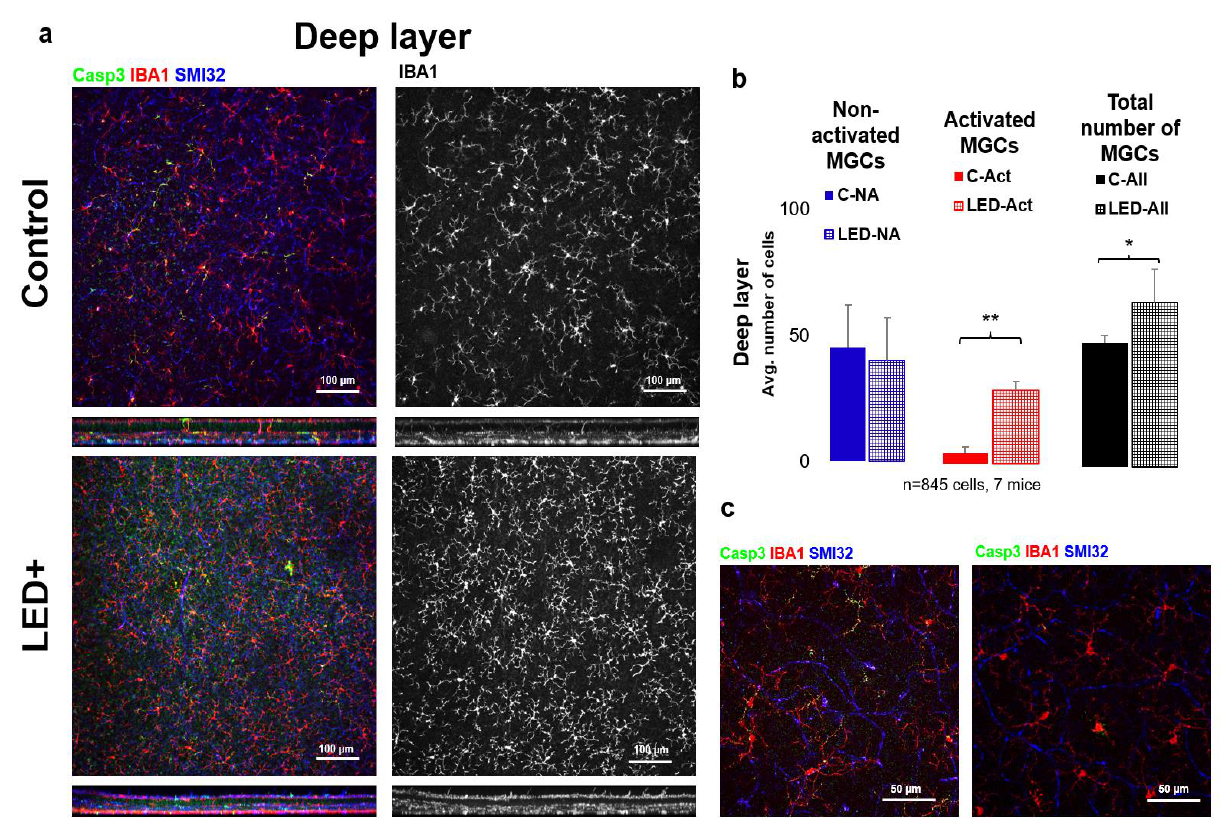
Figure 3. Microglia activation in the deeper parts of the retina. Panel ( a ) of the figure shows the outer or “deep” layer of control and LED retinas, labeled with SMI32 (neuron marker), Iba1 (microglia marker), and Casp3 (Casp3 + cells) scanned with a 20 × objective (pictured). The colors shown are the same as the colors above the images. In the second column, only Iba1-labeled microglia are shown in white. In ( b ) the histogram shows the number of inactivated, activated, and total microglia counted in the retinal ganglion cell layer and inner fibrous layer (* p = 0.05; ** p = 0.01). ( c ) Shows confocal microscopic images scanned with a 63x objective of activated MGs (left) and non-activated MGs (right).